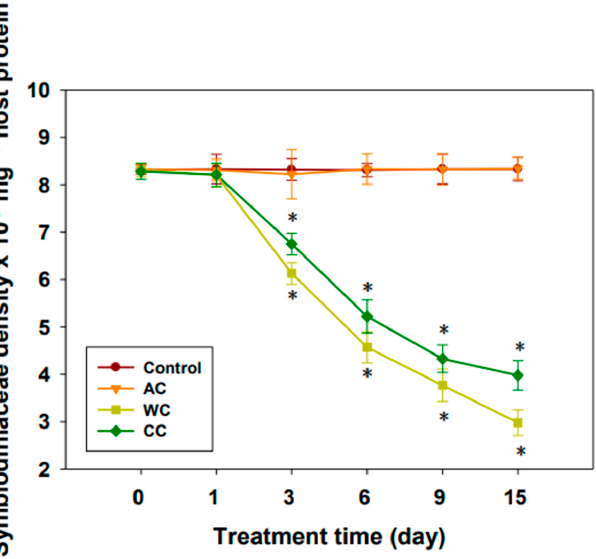
Figure 2. Consequences of different stresses on Symbiodiniaceae density ( n = 3). AC, acidification conditions; WC, warming conditions; CC, combined conditions. Asterisks (*) indicate p -values < 0.05.